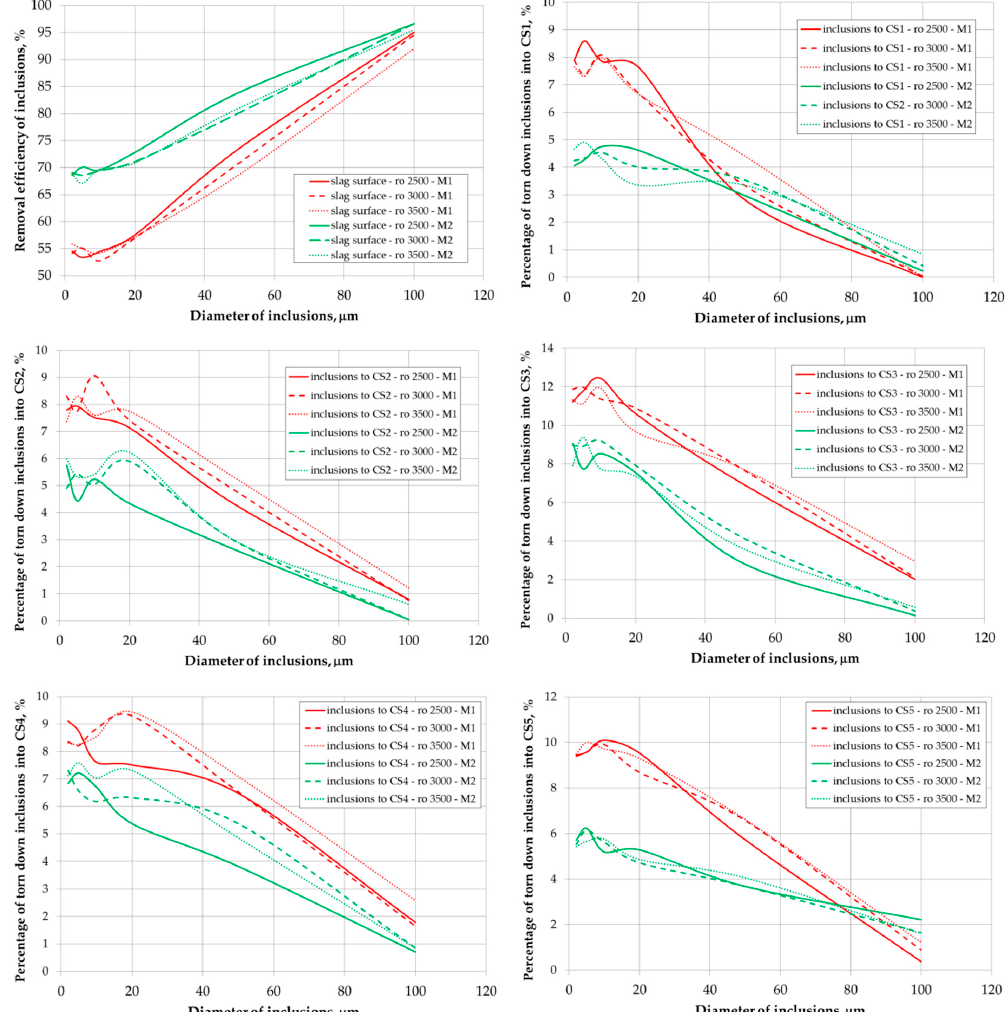
Figure 11. Comparison of the proportions of inclusions removed into the slag and torn down into casting strands for the fractions represented in the steel stream through a shroud tube by a 100% share. Table 8. Comparison of residence times of inclusions and efficiency of their removal through the melt surface for individual fractions represented in the steel casting strand through a shroud tube by a 100% share.